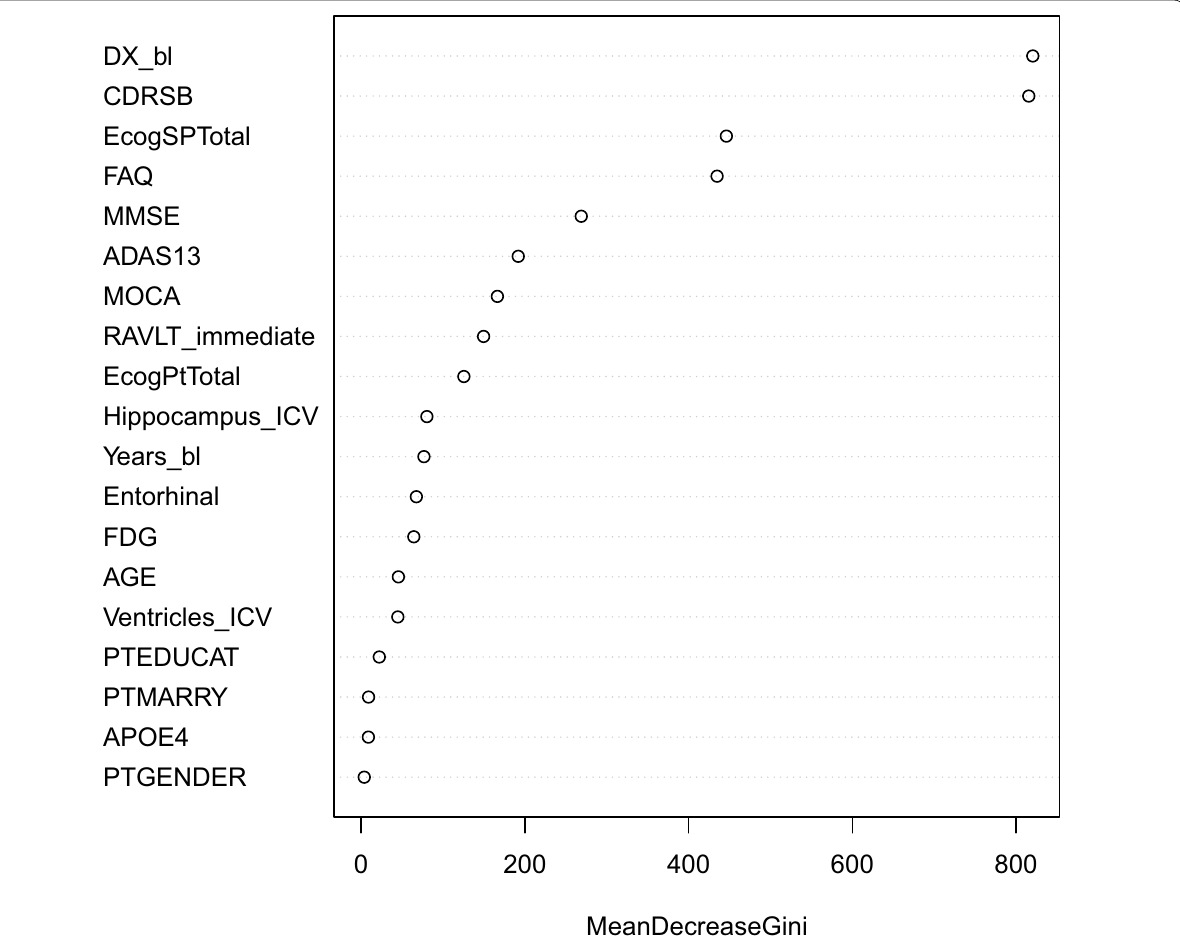
Fig. 5 Random forest variable importance for categorical diagnosis (cognitively normal, mild cognitive impairment, or dementia). ADAS13 Alzheimer’s Disease Assessment Scale, CDRSB Clinical Dementia Rating—Sum of Boxes, EcogPtTotal everyday cognition participant, EcogSPTotal everyday cognition study partner, FAQ Functional Assessment Questionnaire, FDG FluoroDeoxyGlucose, MMSE Mini-Mental State Examination, MOCA Montreal Cognitive Assessment, RAVLT Rey Auditory Verbal Learning Test, ICV intracranial volume, PTGENDER participant’s gender, PTMARRY participant’s marital status, PTEDUCAT participant’s education, Year_bl years from baseline, DX_bl baseline diagnosis, APOE4 APOE e4